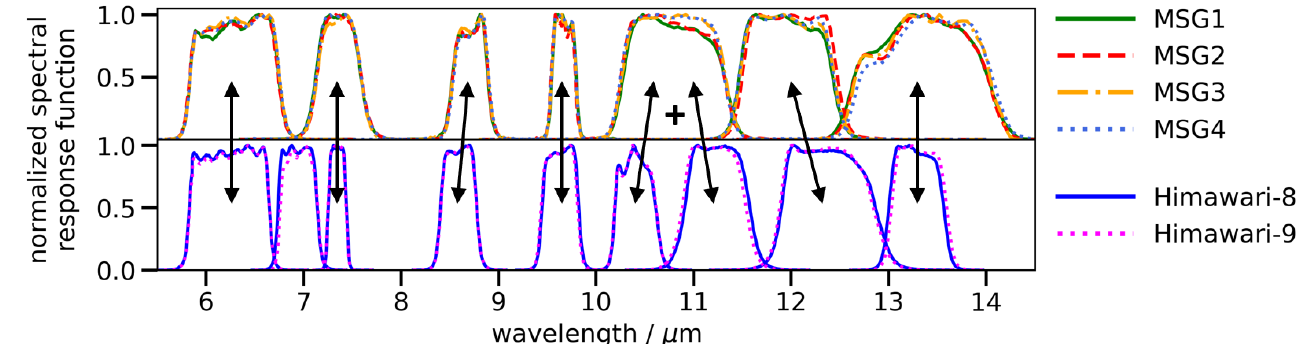
Figure 3. Peak-normalized spectral response functions of different versions of MSG/SEVIRI and Himawari/AHI. The arrows indicate corresponding channels in both instrument, i.e., channels that have approximately the same central wavelengths. In the special case of the MSG/SEVIRI channel at 10.8 µ m, two channels at Himawari/AHI are equally close but shifted to the upper and the lower end of the band; thus, the mean of both channels is used for the naive SBAFs instead of Equation(6).